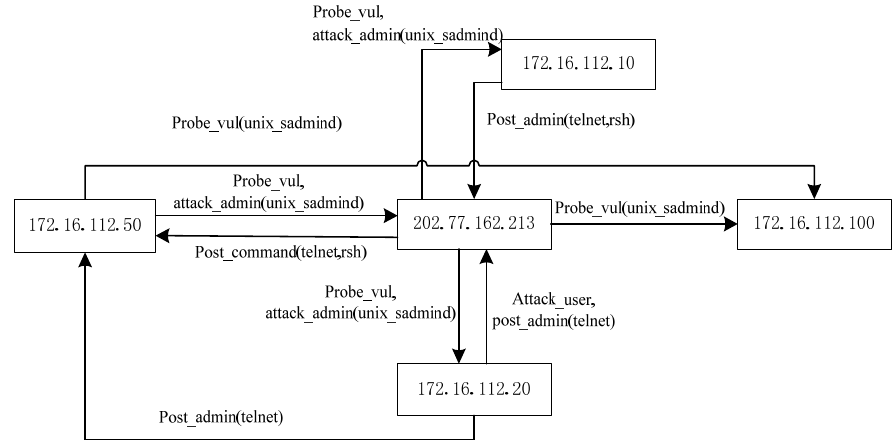
Figure 10. Wang’s simplified evidence graph (omission of the DDoS attack).